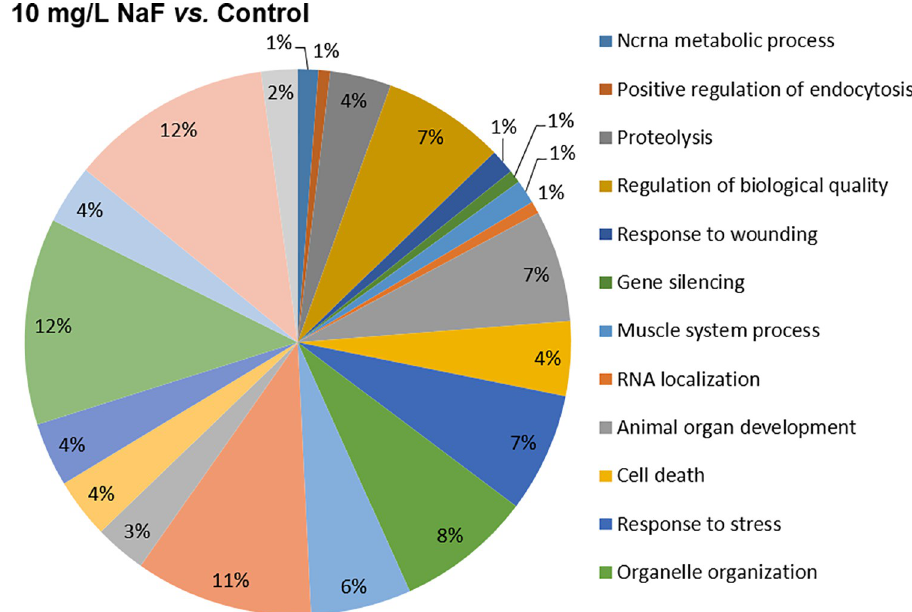
Fig 4. Functional distribution of proteins (10 mg/L of F vs. control group). Functional distribution of proteins identified with different expressions in the parotid glands of mice (n = 30, 10 per group) exposed for 60 days to 10 mg/ L vs . 0 mg/L of F. Categories of proteins based on gene ontology (GO) selected for biological processes. Significant terms (Kappa = 0.4) and distribution according to percentage of number of gene associations. The protein accession number was provided by the Uniprot database. The GO was evaluated according to Cytoscape 1 software 3.4.0, using the ClueGo 1 plugin.